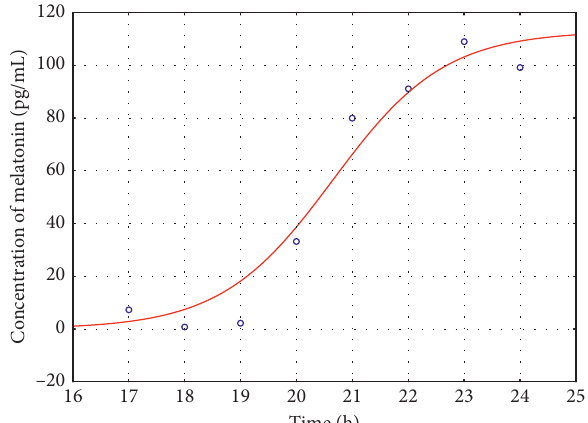
Figure 2: The salivary melatonin onset for the exemplary patient with hypoxic ischemic encephalopathy—the estimated model; and o are the measured values.